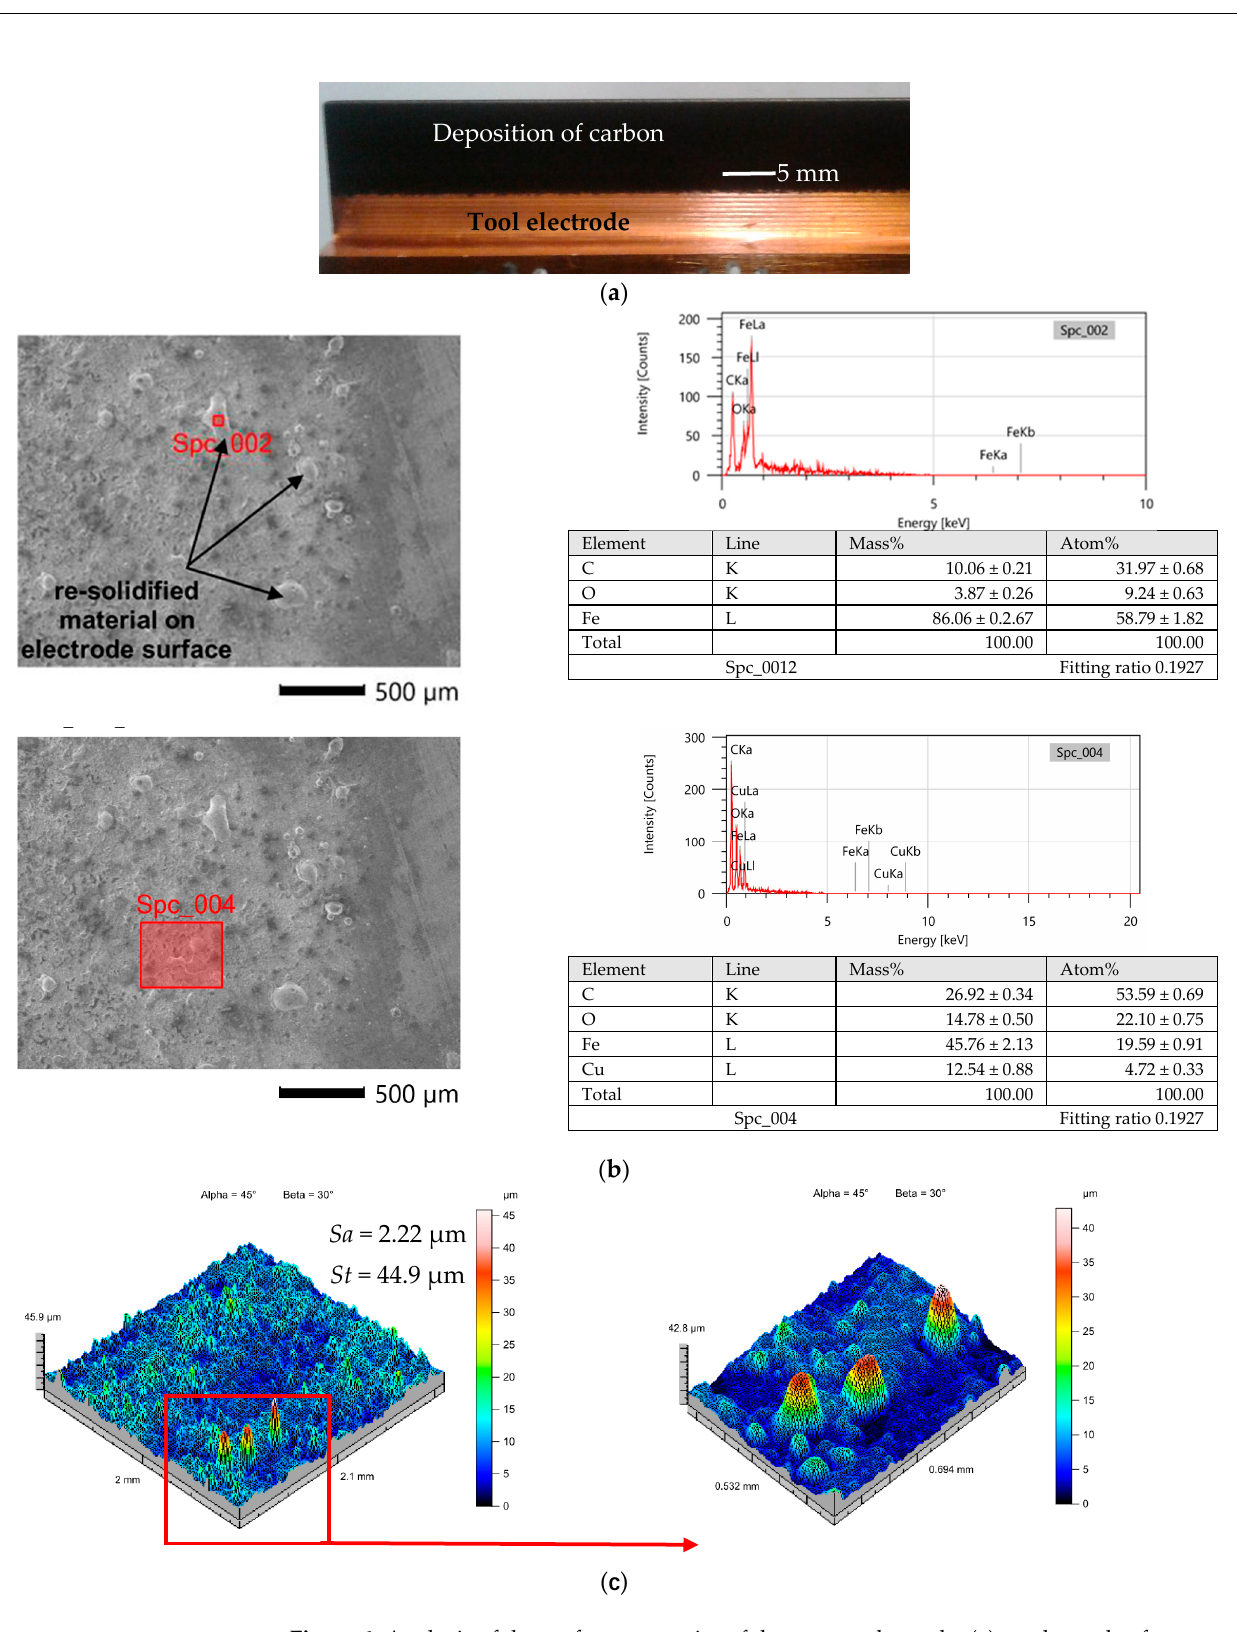
Figure 6. Analysis of the surface properties of the copper electrode: ( a ) an electrode after manufacturing slot; ( b ) EDS spectrum of the surface of the copper electrode, ( c ) measured topography of the surface with marked peaks.